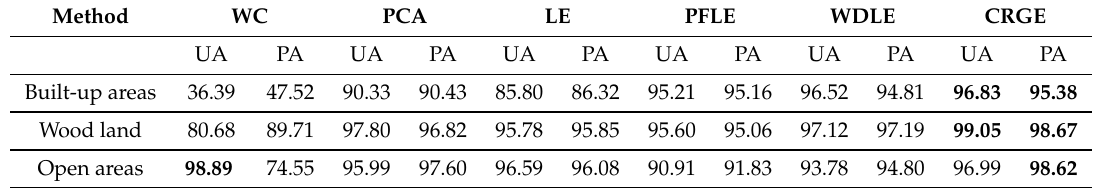
Table 3. Classification accuracies of six methods on the Oberpfaffenhofen data set.